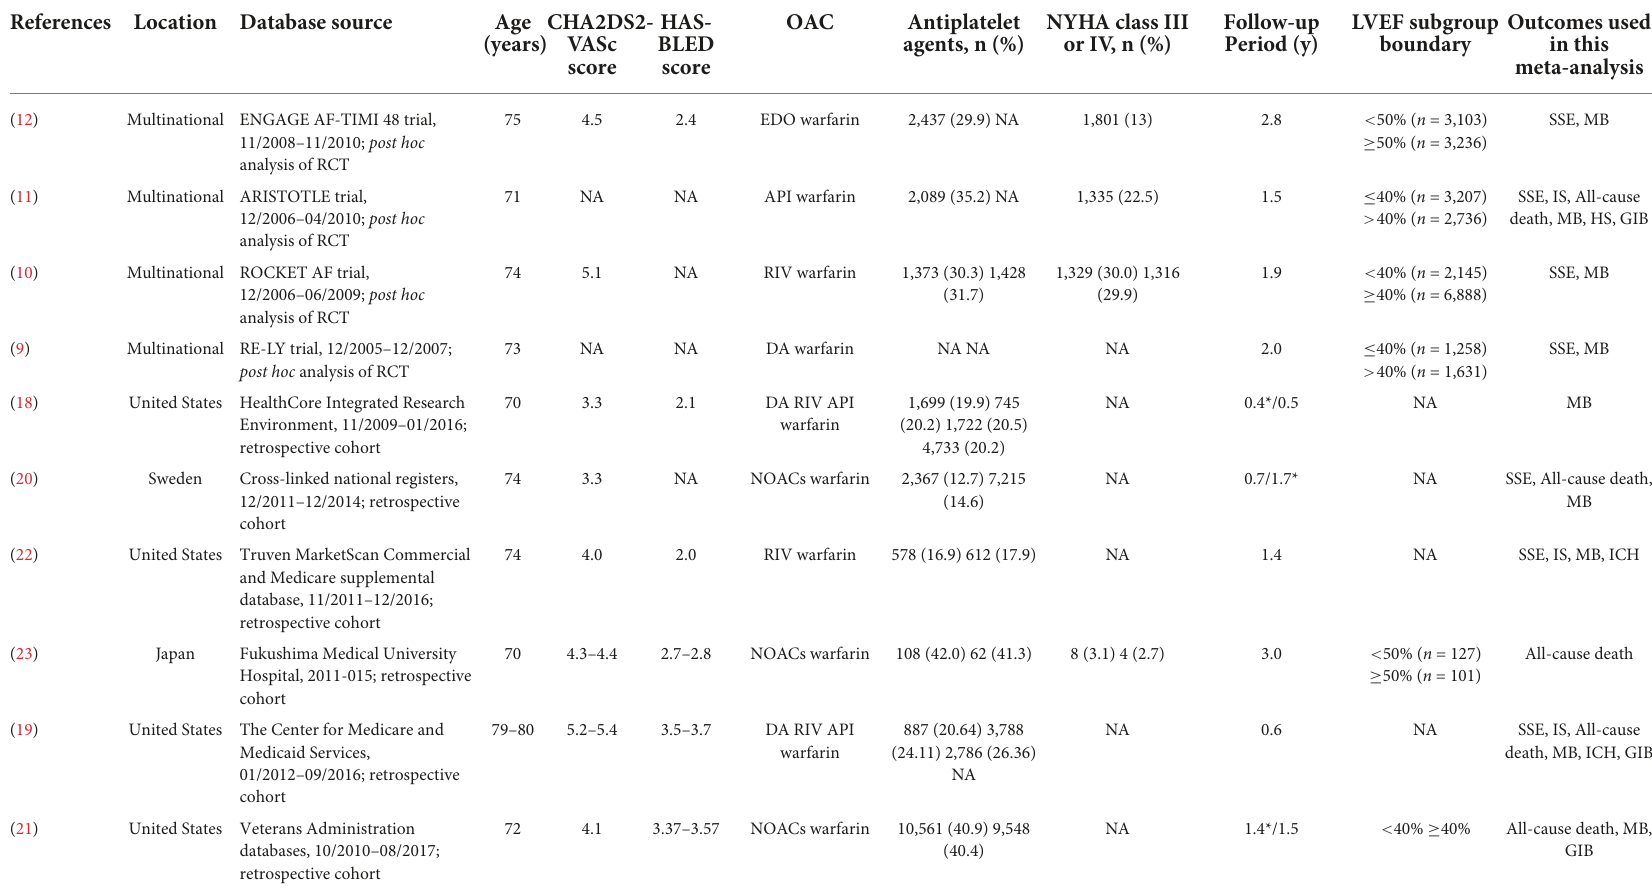
TABLE 1 Patients’ characteristics of the selected studies for this